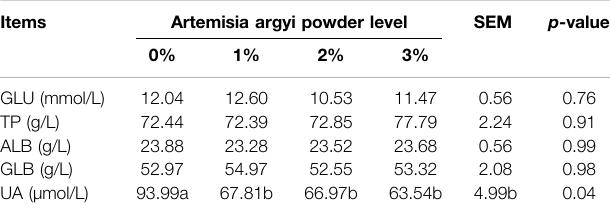
TABLE 4 | Effects of Artemisia argyi on Serum Biochemical Indices of Roman Laying Hens.